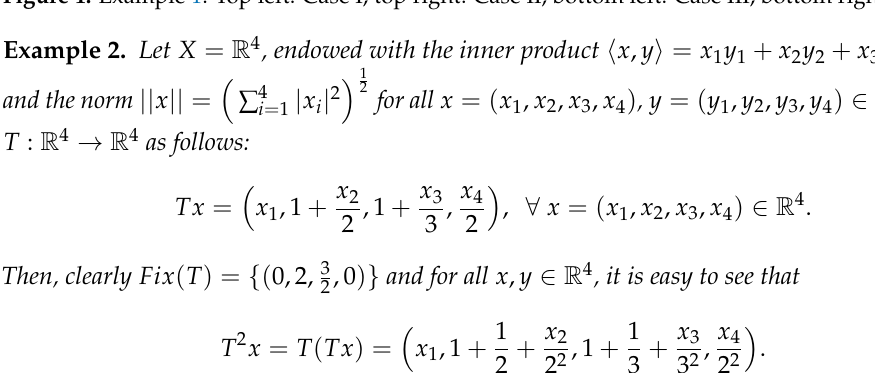
Figure 1. Example 1. Top left: Case I; top right: Case II; bottom left: Case III; bottom right: Case